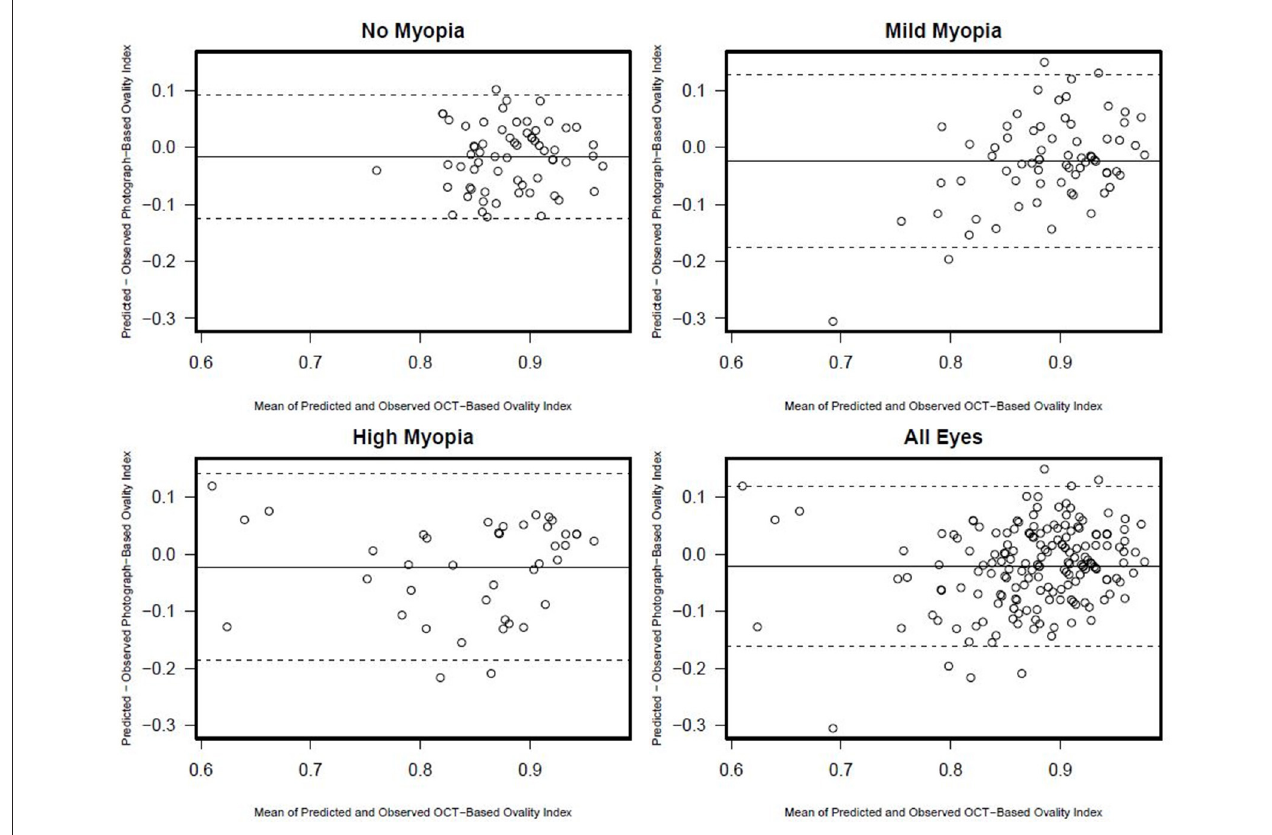
FIGURE 4 | Ovality index Bland-Altman plots documenting the agreement between photograph and OCT-based ovality index by myopia